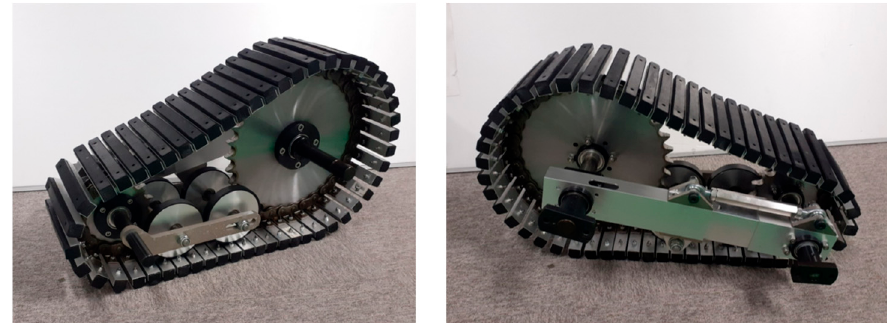
Figure 2. Scheme of the main components of the model. Ground, indicated with the letter G, represents the soil; Frame, indicated with the letter F, represents the vehicle chassis; Track module, indicated with the letter T, is a set of bodies assembled to form the system shown in Figure 3. The assembly in Figure 4 is hinged to the vehicle chassis (F) through a revolute joint located at point T 1 ;